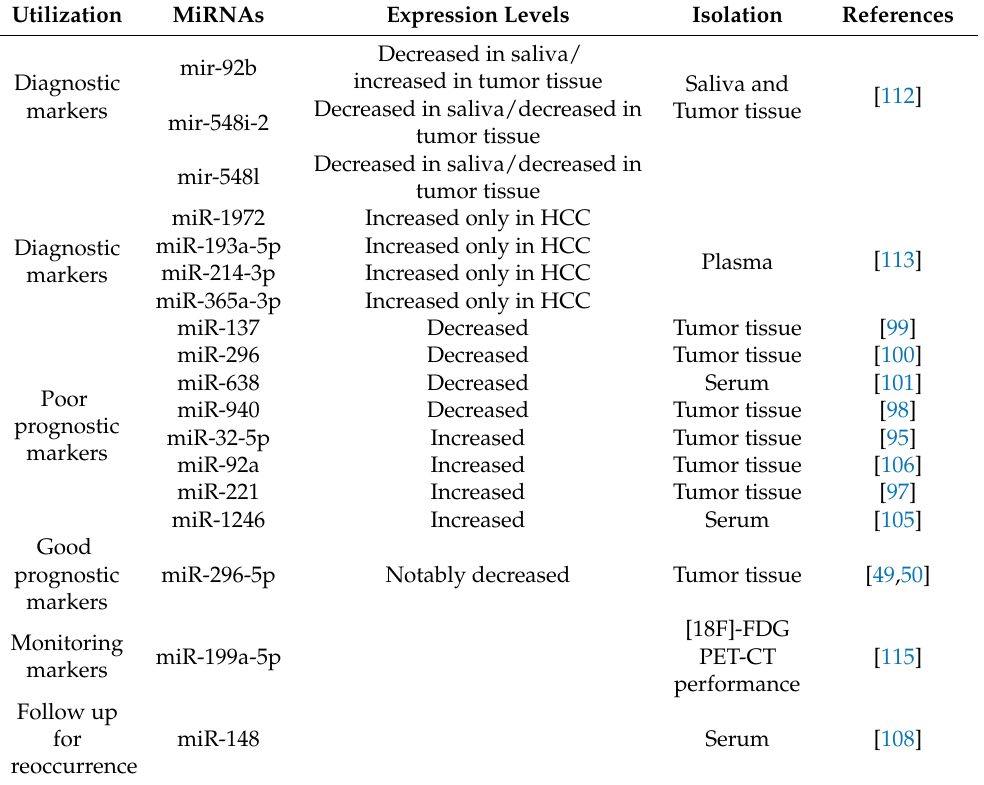
Table 3. Summary of miRNAs expression levels and their utilization in HCC